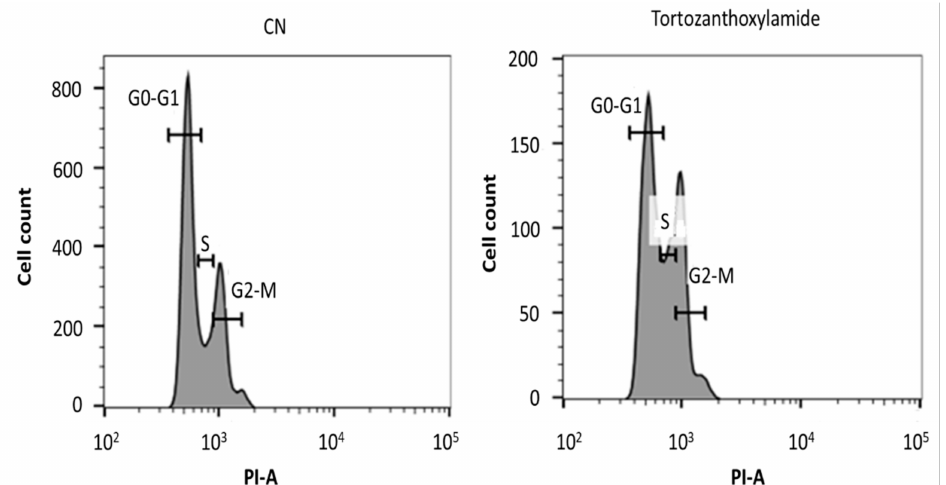
Figure 5. A typical histogram depicting the e ff ects of tortozanthoxylamide ( 1 ) on the cell cycle phases (G0-G1, S and G2-M) of T. brucei subsp. brucei . PI is propidium iodide; CN is negative